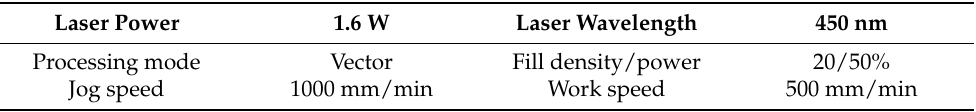
Table 2. Parameters used for laser engraving of microfluidic channel structures into black poly methylmethacrylate